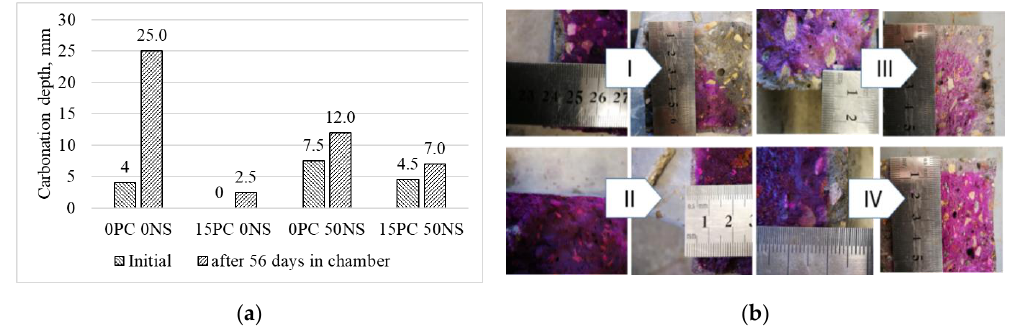
Figure 7. The depth of AAC samples carbonation ( a ) and the samples after carbonation tests ( b ). Notes: I—0NS0PC, II—0NS15PC, III—50NS0PC, IV—50NS15PC and the pink zones are uncarbonated parts